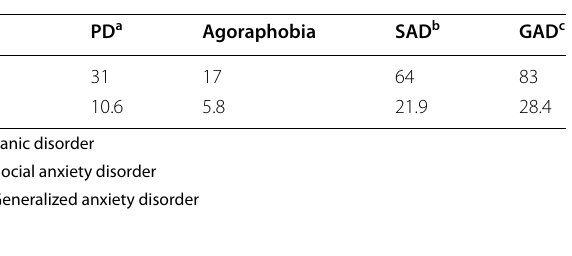
Table 4 Correlations between anxiety disorders and different substances used by patients with substance use disorder